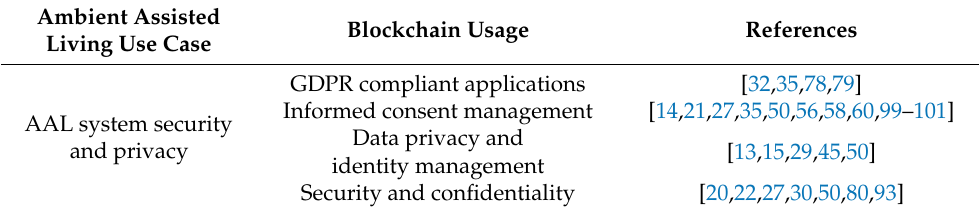
Table 5. Blockchain usage benefits for the security and privacy of AAL